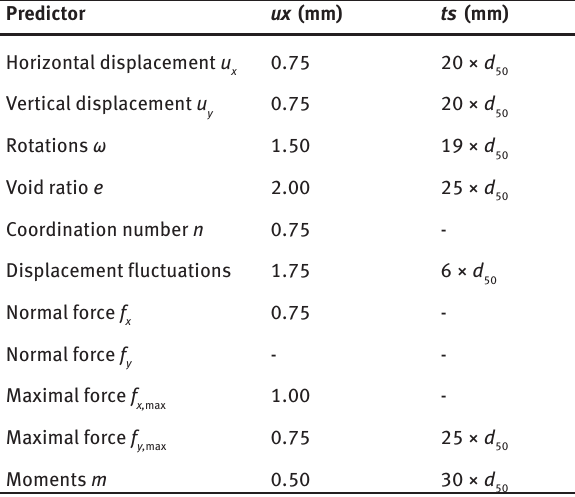
Table 2: Early predictor summation. Predictor